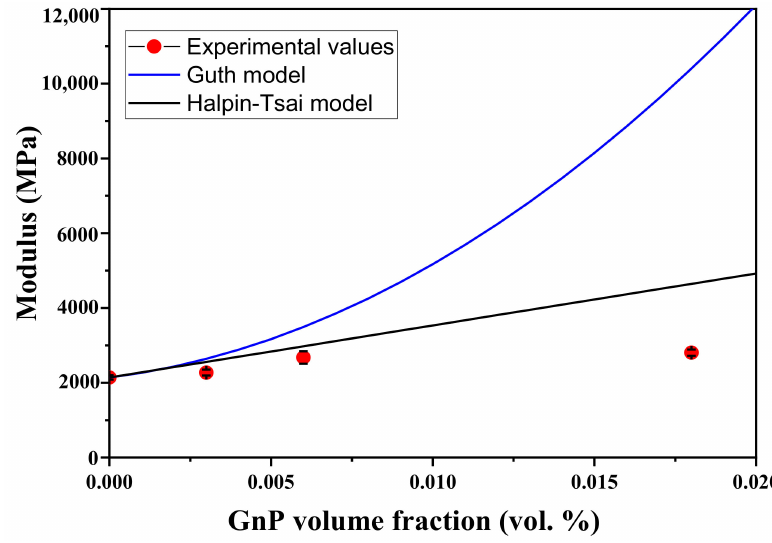
Figure 9. Comparison of experimental modulus with theoretical predictions of nanocomposite models. In contrast, the Guth model displayed a large deviation from the experimental